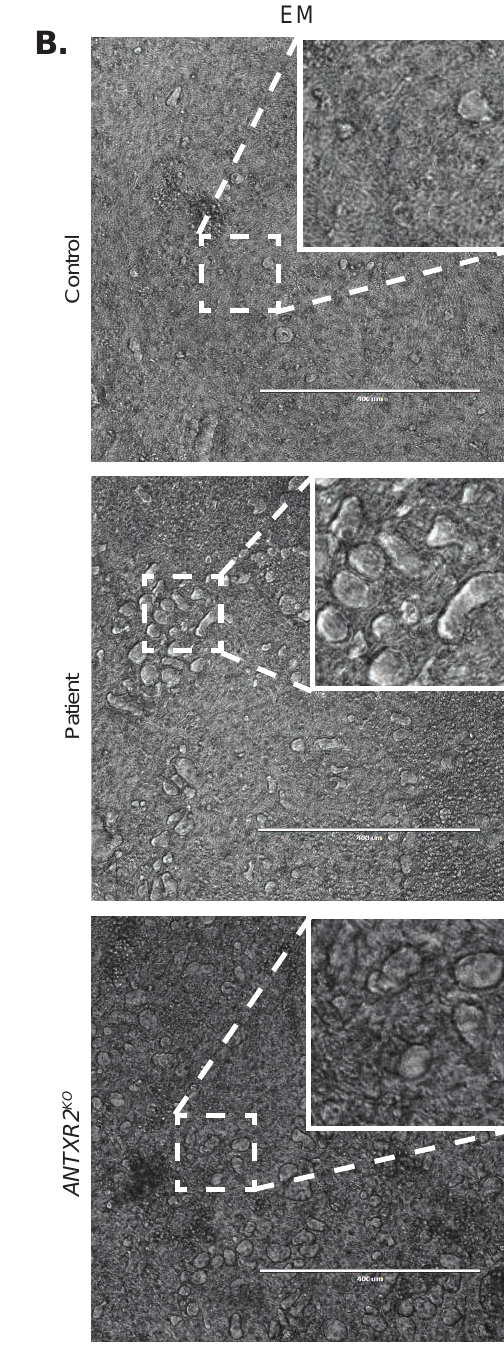
Figure 5. Normal monolayer cultures in ANTXR2-deficient organoids. ( A ) Trans-epithelial electrical resistance measured for control, patient, and ANTXR2 KO organoids. ( B , C ) Monolayers were grown on EM for 7 days. ( B ) Microscopic brightfield images. Inserts show examples of blister formation and ( C ) confocal images for polarization markers, including actin (green, apical membrane), E-cadherin (CDH1, red, basolateral membrane) and DAPI (blue,